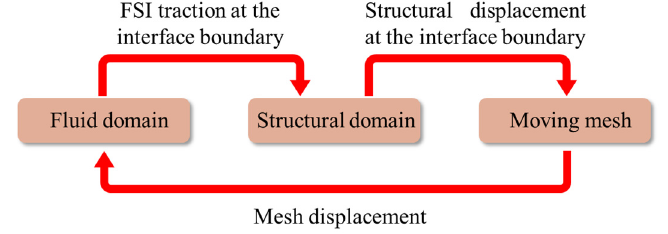
Figure 3. Schematic diagram of FSI.